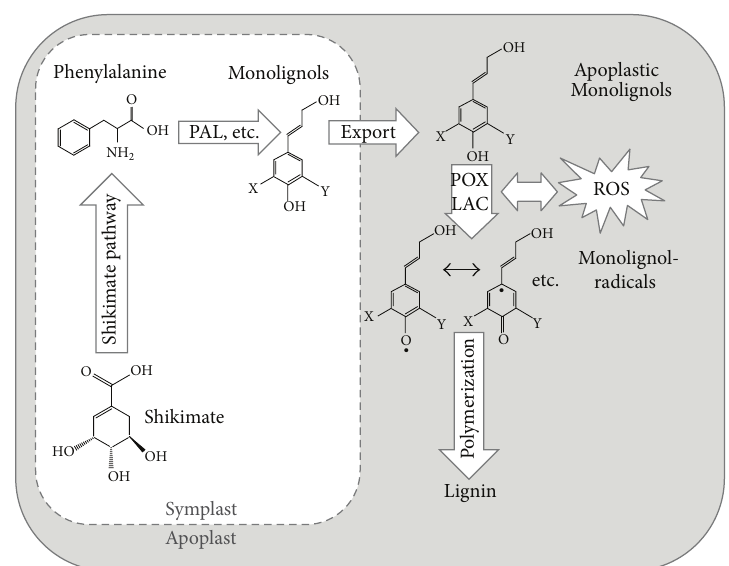
Figure 1: Simplified model of lignin biosynthesis in vascular plants. PAL: phenylalanine ammonia lyase, POX: peroxidases, LAC: laccases, and ROS: reactive oxygen